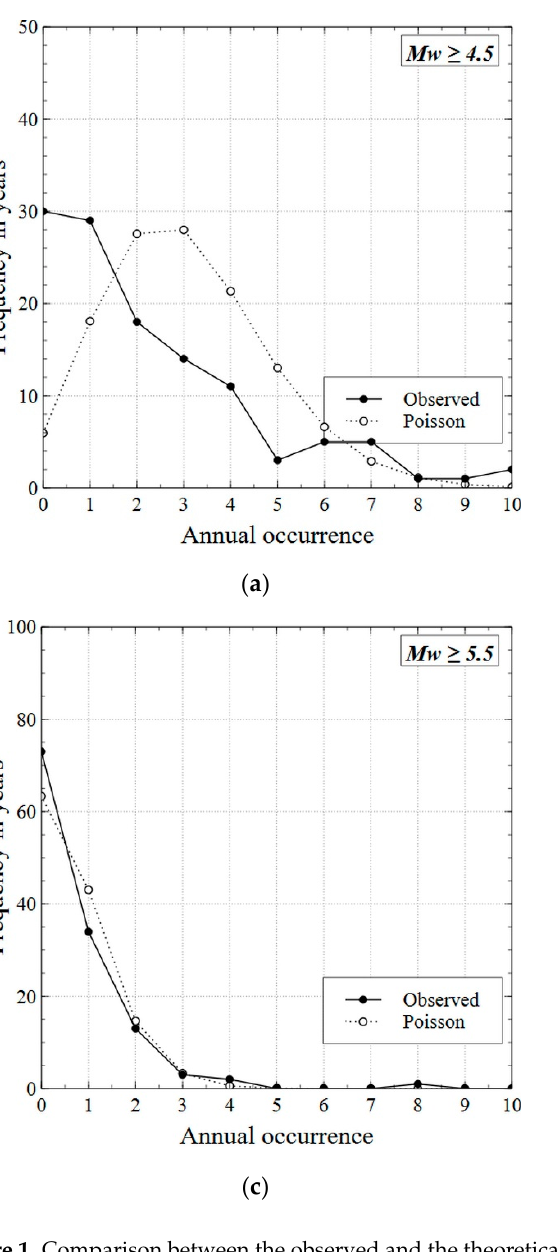
Figure 1. Comparison between the observed and the theoretical earthquake frequency occurrence for earthquakes occurring in the Vrancea intermediate-depth seismic source with: ( a ) M W ≥ 4.5; ( b ) M W ≥ 5.0; ( c ) M W ≥ 5.5; ( d ) M W ≥